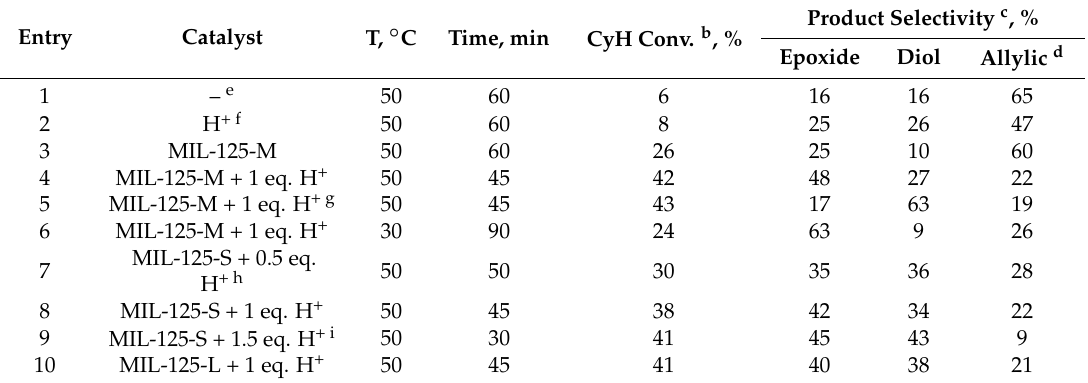
Table 2. CyH oxidation over MIL-125. a